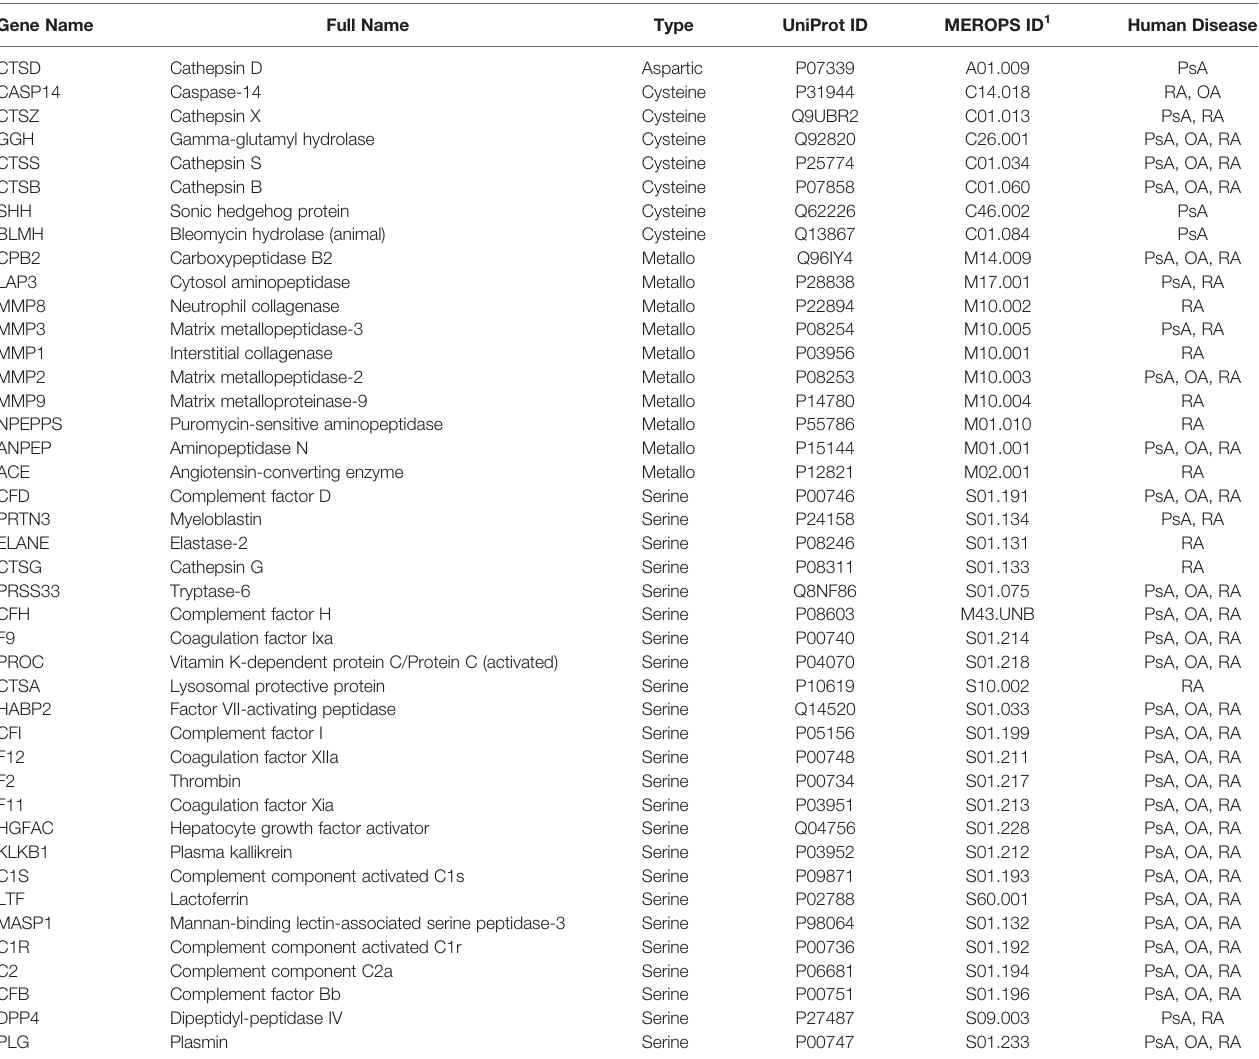
TABLE 1 | List of proteins with proteinase sequences identi fi ed in SF of PsA, OA and RA